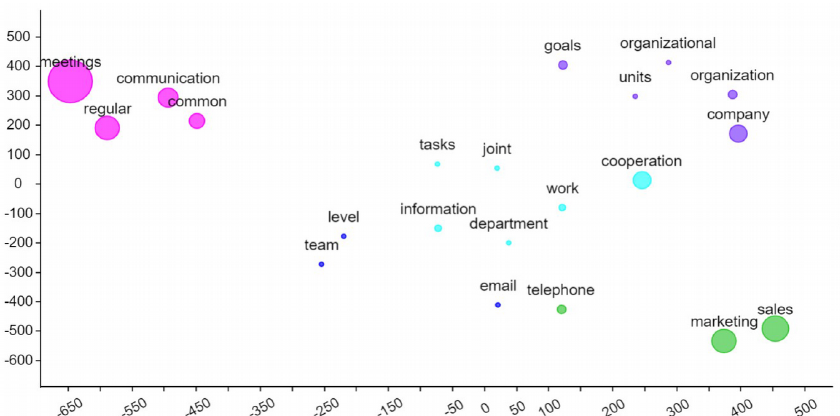
Figure 6. t-SNE generated clusters for the answers to Question 3 at perplexity level 5 (Own editing using www.voyant.tools.org )